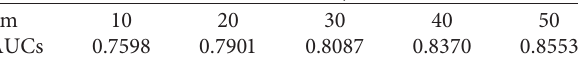
Figure 4: Performance comparison about the PR curve. Table 1: Parameter analysis for km.